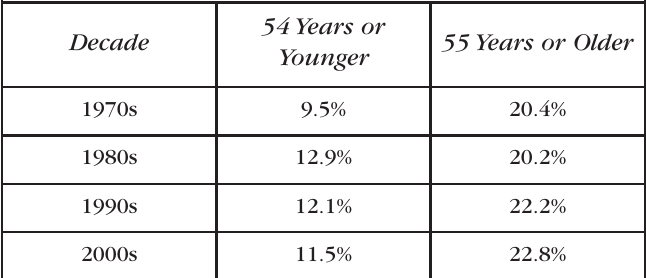
Table 4. Percentage of Self-Employed Respondents Working Full or Part Time by Decade